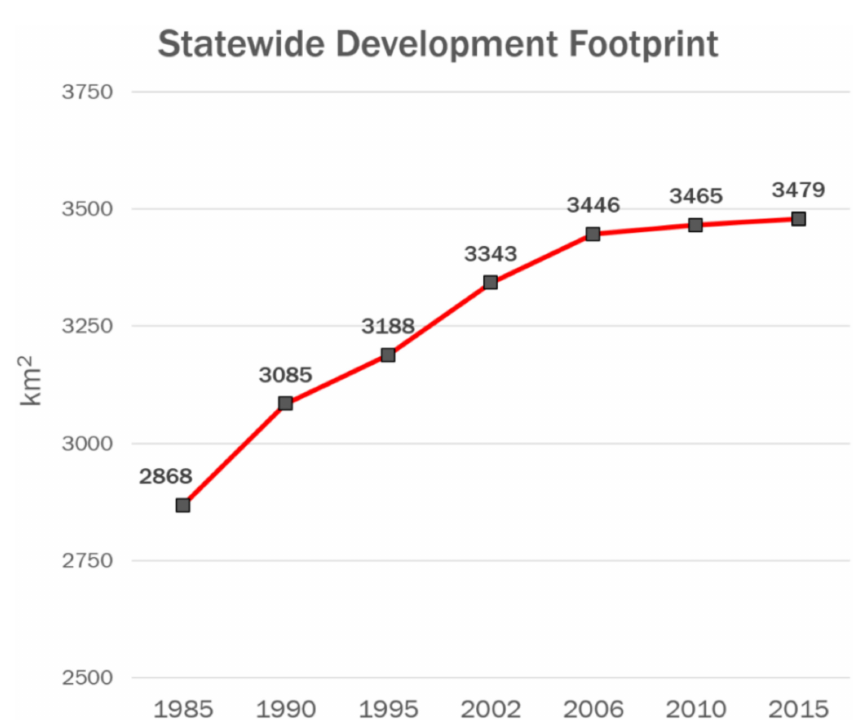
Figure 13. Area of “development footprint” (sum of developed and turf and grass categories) over the study period from 1985 to